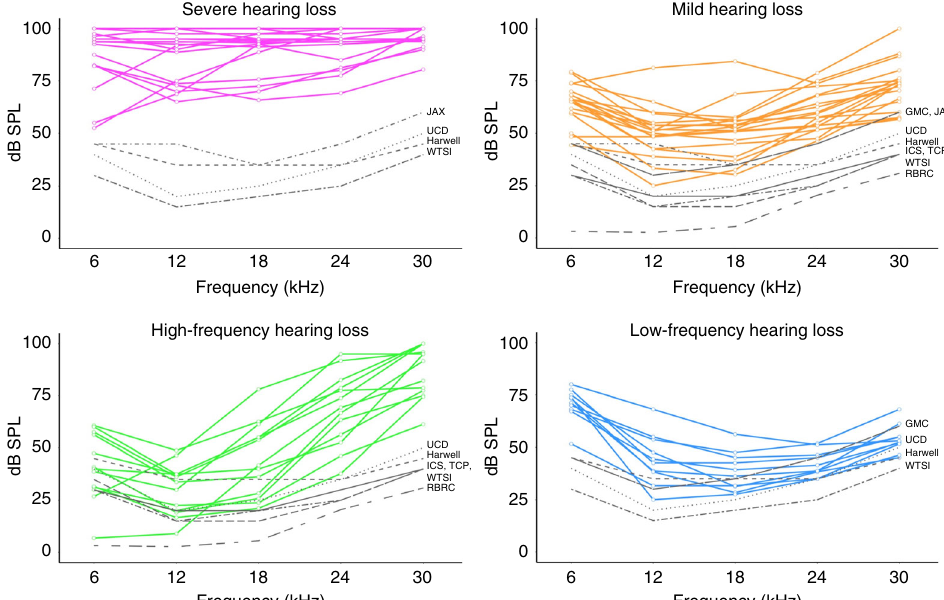
Fig. 2 Summary audiograms for the 67 hearing loss genes identi fi ed within the IMPC. ABR screen assessing auditory thresholds (dB SPL) at fi ve frequencies — 6, 12, 18, 24 and 30 kHz. The genes are divided into four broad categories of hearing loss — severe ( magenta lines ), mild ( orange lines ), high frequency ( green lines ) and low frequency ( blue lines ). In each category, the median of auditory thresholds for control mice for each of the contributing centres to genes in that category is shown ( black lines ). GMC, Helmholtz Zentrum Munchen; Harwell, MRC Harwell; ICS, Institut Clinique de la